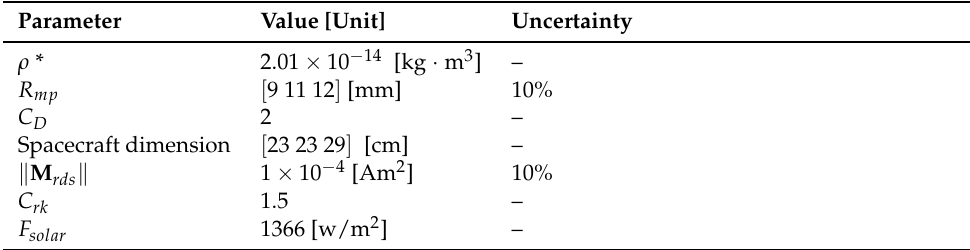
Table 2. Disturbance